Question: What form of chart is displayed?
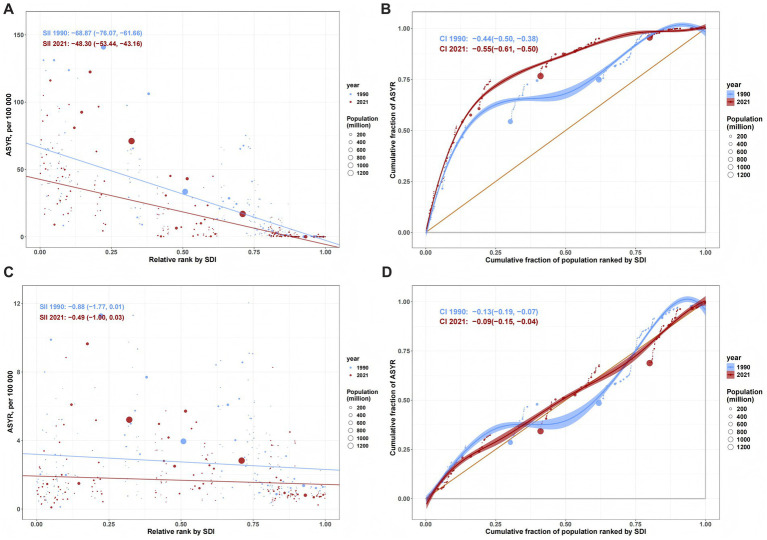
Answer: line